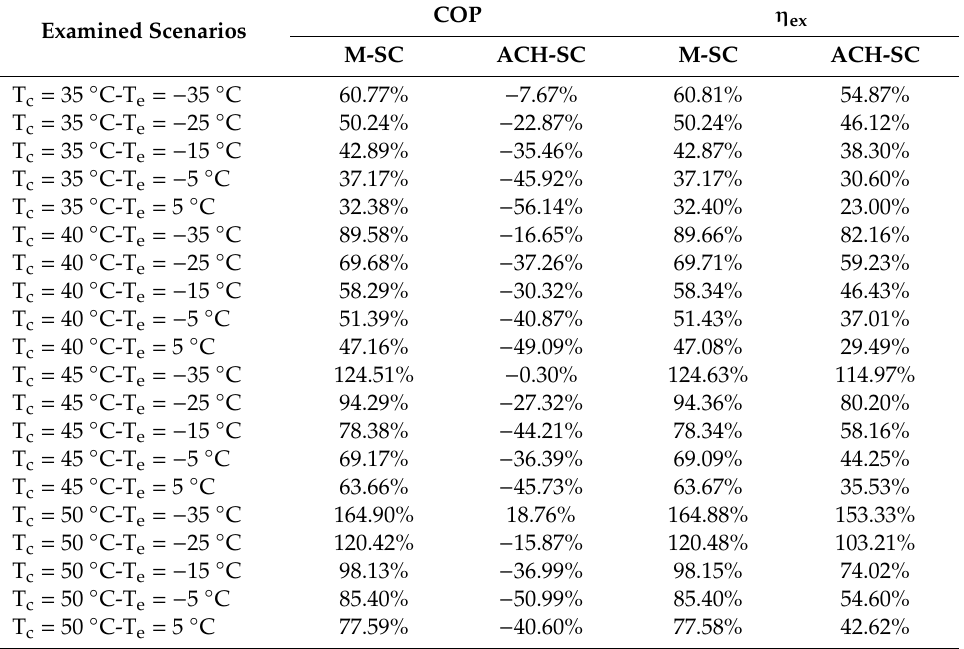
Table 3. COP and exergy e ffi ciency deviation compared to the reference system for all the examined operating